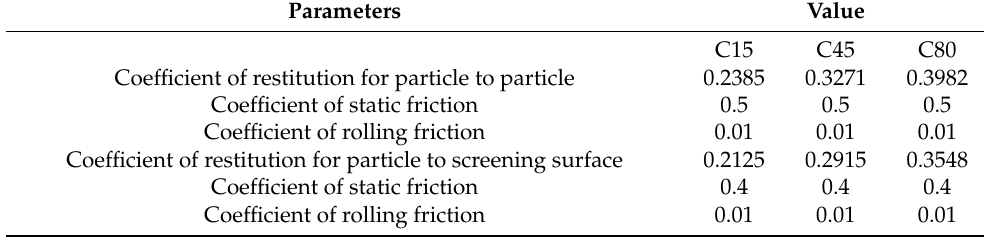
Figure 3. The relation between the particle radius and the coefficient of restitution. Table 3. Particle material parameters of C15, C45, C80 concrete used in the simulations.